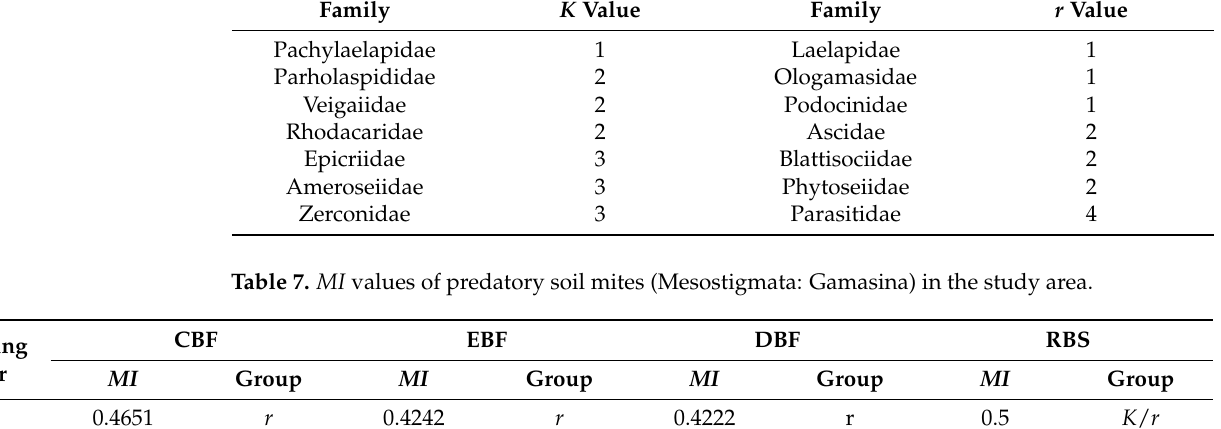
Table 6. K - or r -values of predatory soil mites (Mesostigmata: Gamasina) in the study area. Family